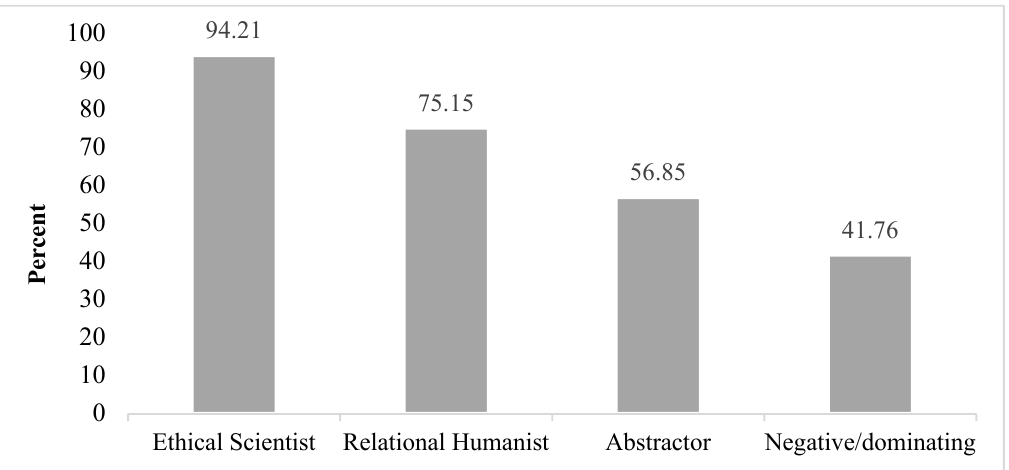
Figure 2. Percent response to 26 statements on a five-point Likert Scale representing four perspectives about birds in Pennsylvania ( n = 656).